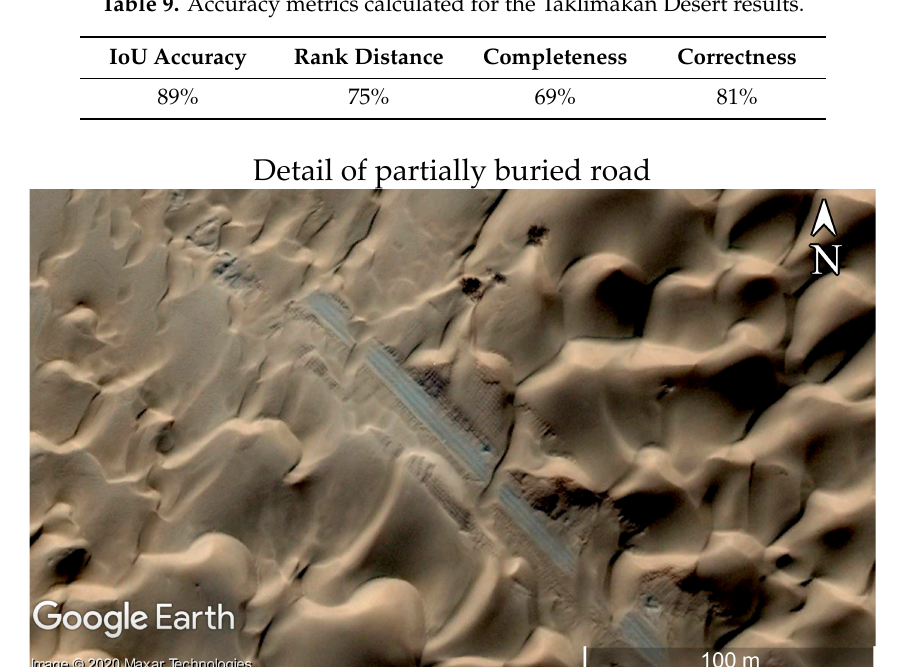
Figure 20. Close–up of a road segment in VHR optical data available on Google Earth Pro. The area corresponds with that shown by the red arrow in Figures 17–19. The road appears to be partially buried, while the output of the model shows a continuous line. It would appear the road was cleared some time between the acquisition of this image and the date range of the Sentinel–1 time series used as the model input. The imagery date is reported to be 26 October 2014.